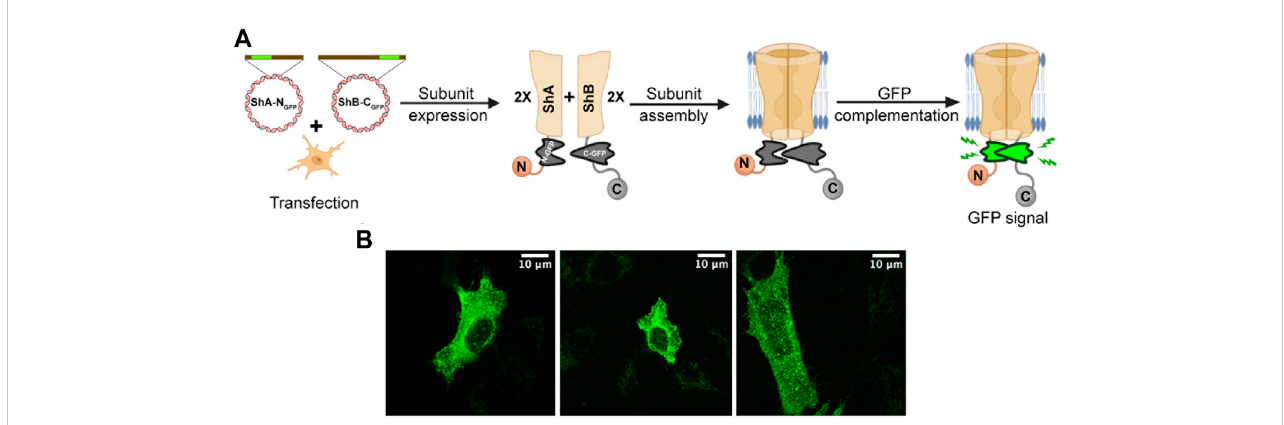
FIGURE 3 Direct demonstration of hetero-oligomeric Kv channel assembly. (A) Schematic representation of the GFP complementation assay used to directly demonstratehetero-oligomeric assembly of Kv channels composed of both the A and B subunits (see text). (B) Confocal microscopy images of three distinct SH-SY5YcellstransfectedwithDNAencodingboththe A and B channelvariants(ata1:1ratio),eachfusedtoahalfofGFP(N GFP andC GFP ,respectivelyfusedto the A and B subunits). The green fl uorescence signal directly indicates intra-molecular assembly of the A and B subunits to form hetero-oligomeric